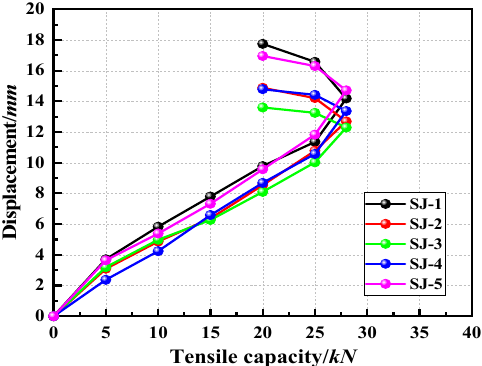
Table 1. Displacement changes of the horizontal bar socket under tensile force.